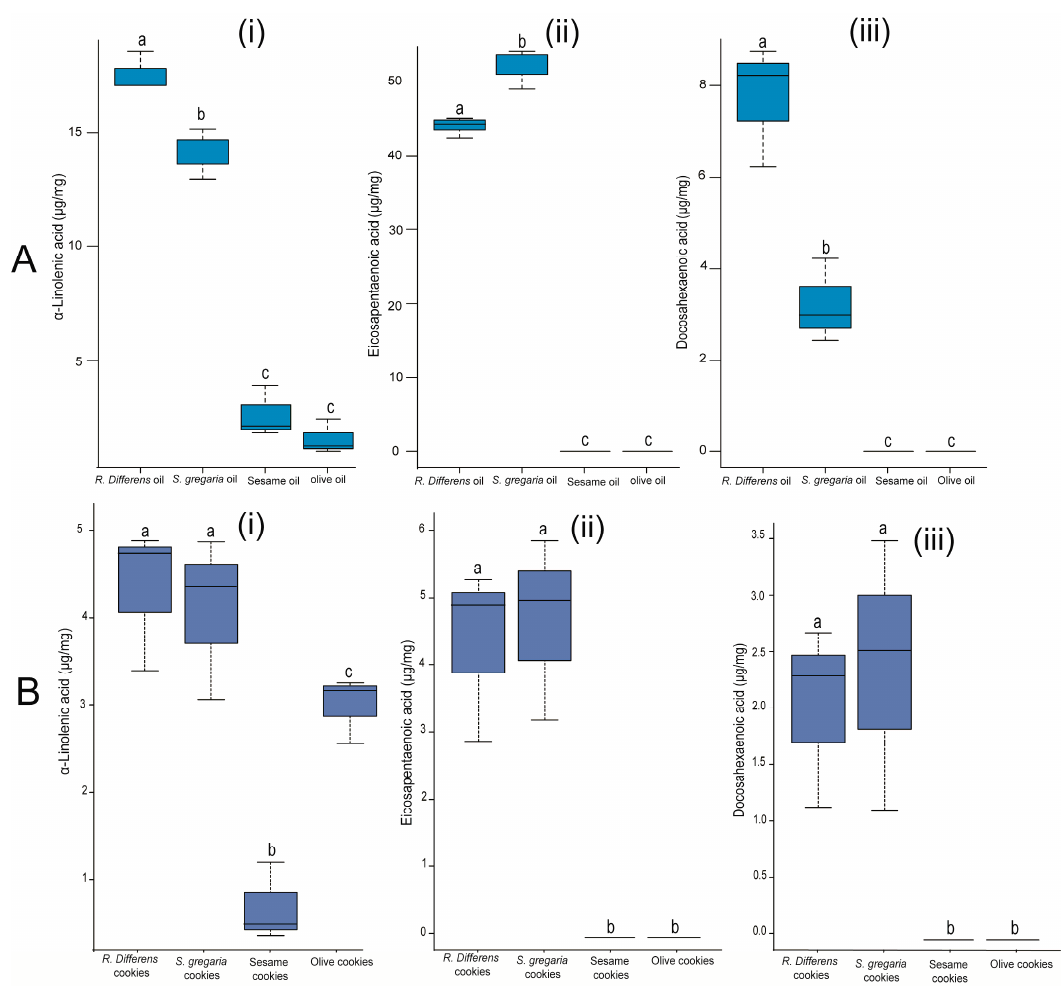
Figure 6. Boxplot illustrating the variation of ( i ) α -linolenic acid, ( ii ) eicosapentaenoic acid, and ( iii ) docosapentaenoic acid concentrations across the different oil ( A ) and cookie types ( B ). On each boxplot, the minimum and maximum values of all the data are represented by the ends of boxplot whiskers. Treatments with different lowercase letters are significantly different from each other.